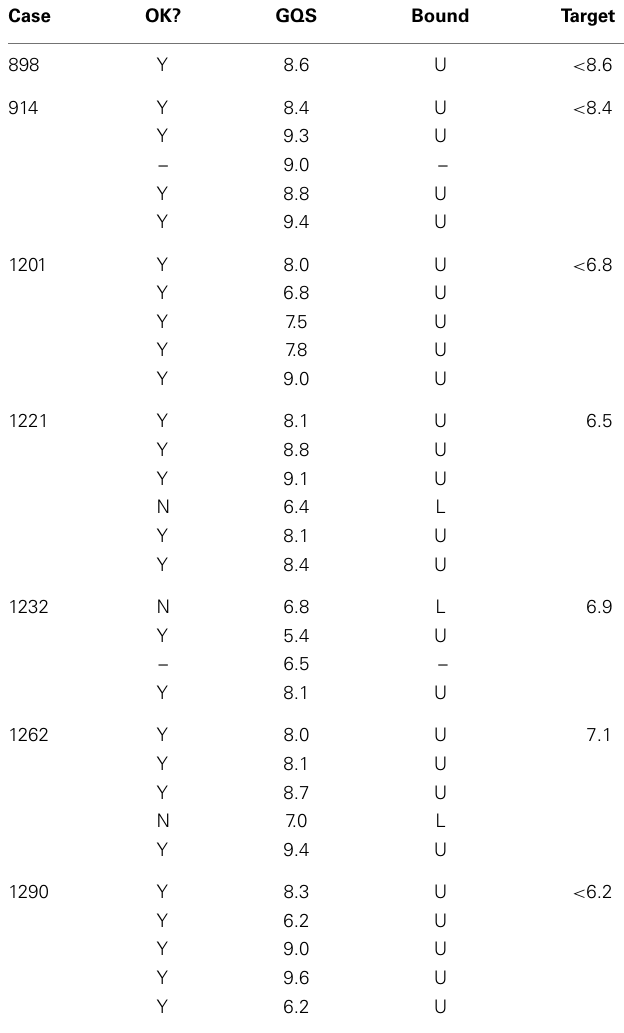
Table 2 | Indirect assessment of case difficulty